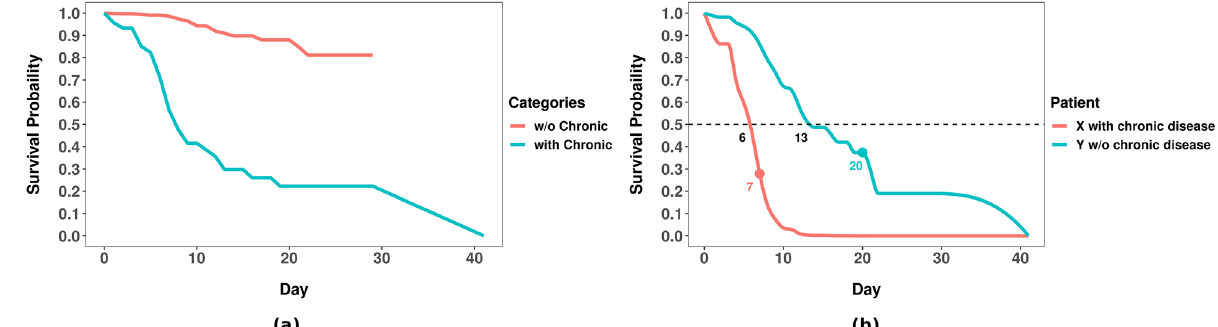
Figure 2. ( a ) KM curves for survival comparison among COVID-19 patients with versus without chronic disease (log-rank p -value < 0.05 ); ( b ) GBCM-KP computed individual survival distributions of two example patients from dataset D2[d]. We show the actual time-to-death for each patient with a solid “ • ”; note these are each close to that patient’s predicted median survival